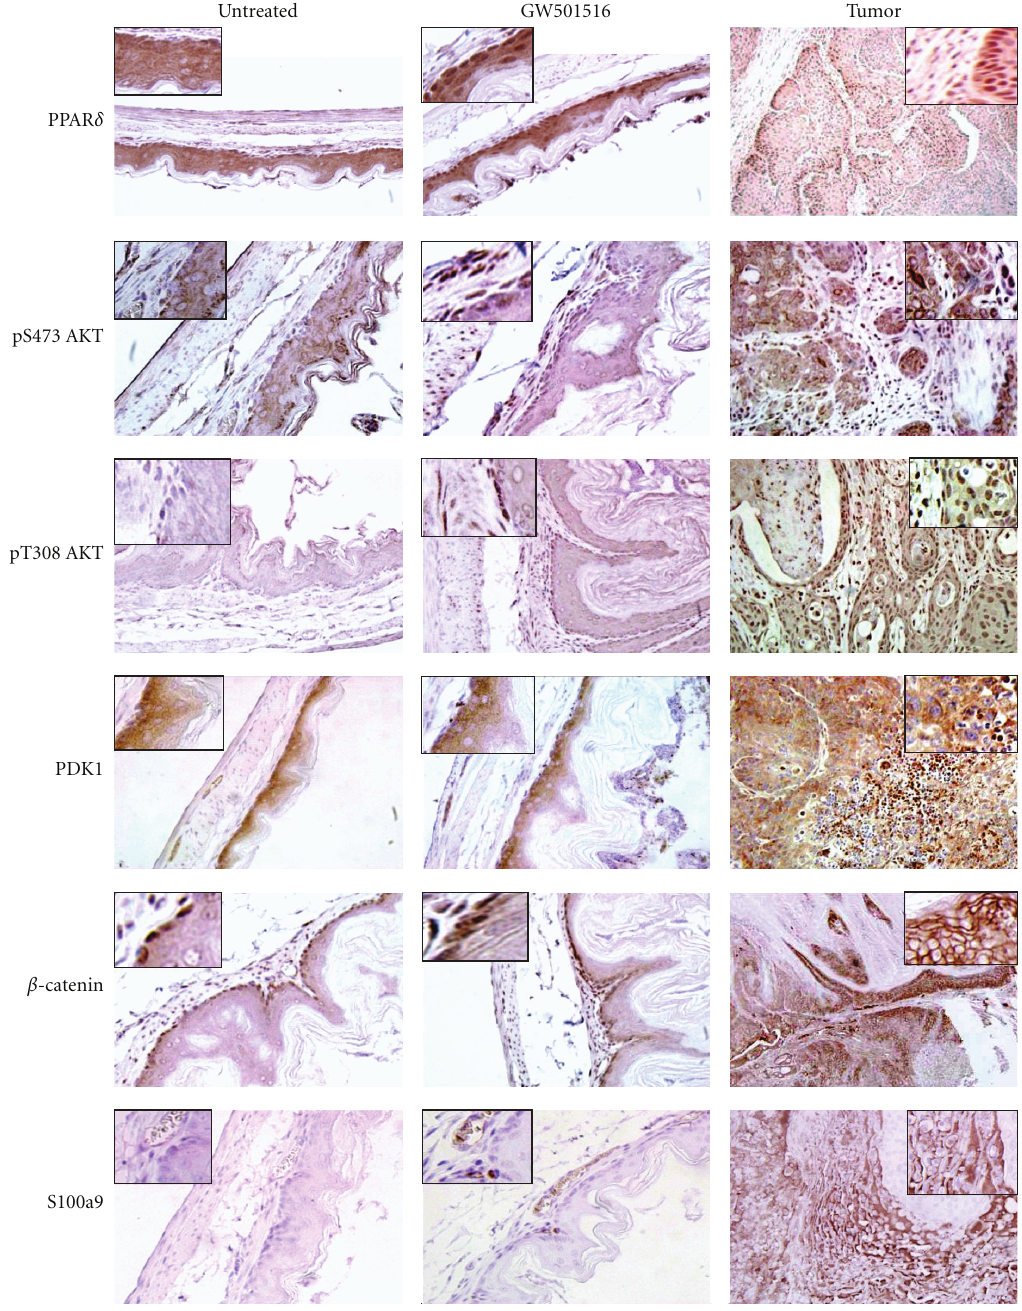
Figure 4: Immunohistochemical analysis of forestomach after GW501516 treatment and gastric tumors. IHC detection of PPAR δ , pS473Akt, pT308 Akt, PDK1, β -catenin, and S100a9. Magnification: untreated and GW501516 treated, 400x; tumor, PPAR δ , PDK1, and β -catenin, 200x; pT308Akt, pS473Akt, S100a9, and 400x. Inset , 2x original magnification. PPAR δ shows di ff use reactivity in untreated gastric